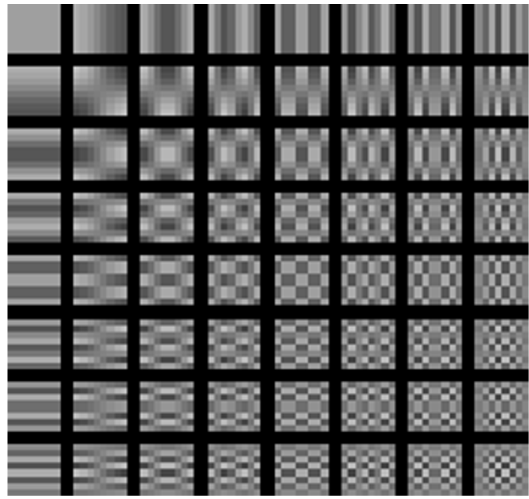
Figure 9. Visualisation of all 64 base vectors of DCT for 8 × 8 pixels images.